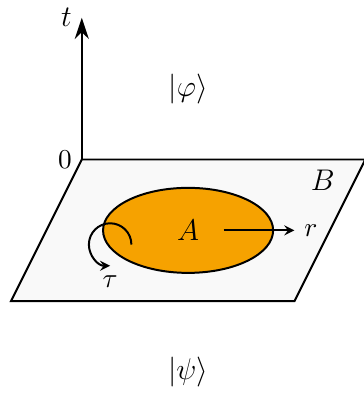
Figure 10 . The spherical entangling surface Σ = ∂A at a time slice ( t = 0 ) in flat space R d